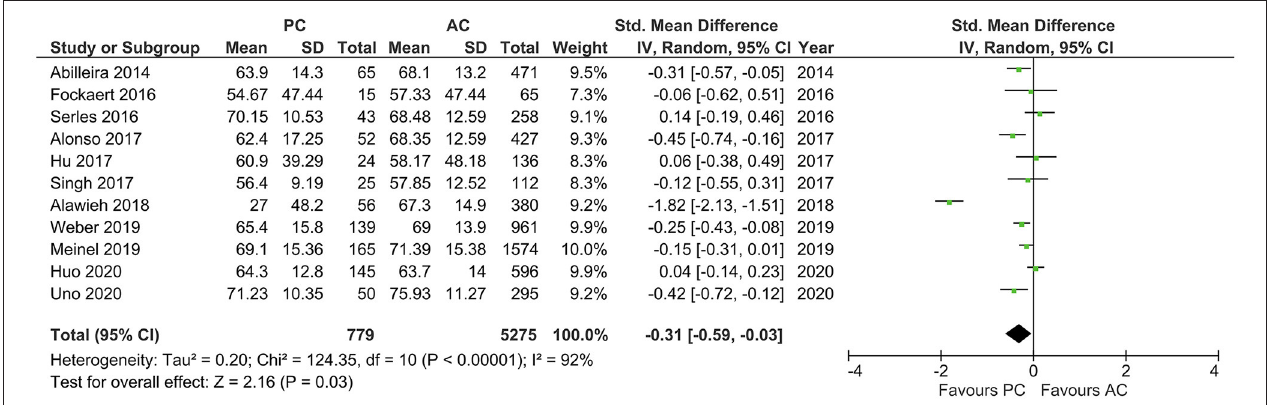
FIGURE 2 | Forest plot comparing “age” of patients with large vessel occlusion in the posterior circulation (PC) vs. anterior circulation (AC) who were treated with endovascular mechanical thrombectomy. Chi 2 , chi-square statistic; CI, confidence interval; df, degrees of freedom; I 2 , I -square heterogeneity statistic; IV, weighted mean difference; P , p -value; SD, standard deviation; Std., standardized; Tau 2 , estimated variance of underlying effects across studies; Z , Z statistic.